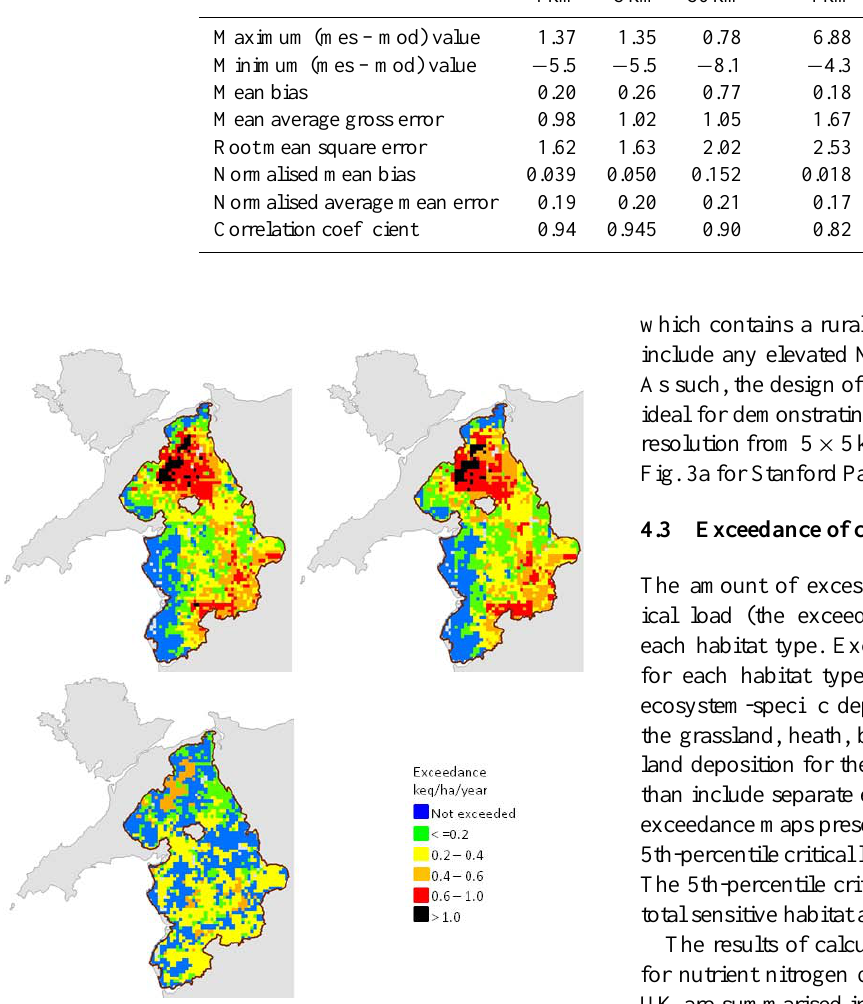
Fig. 6b. Exceedance of 5th percentile nutrient nitrogen critical loads for Snowdonia using model deposition data with resolutions of: 1km (upper left); 5km (upper right); 50km (lower